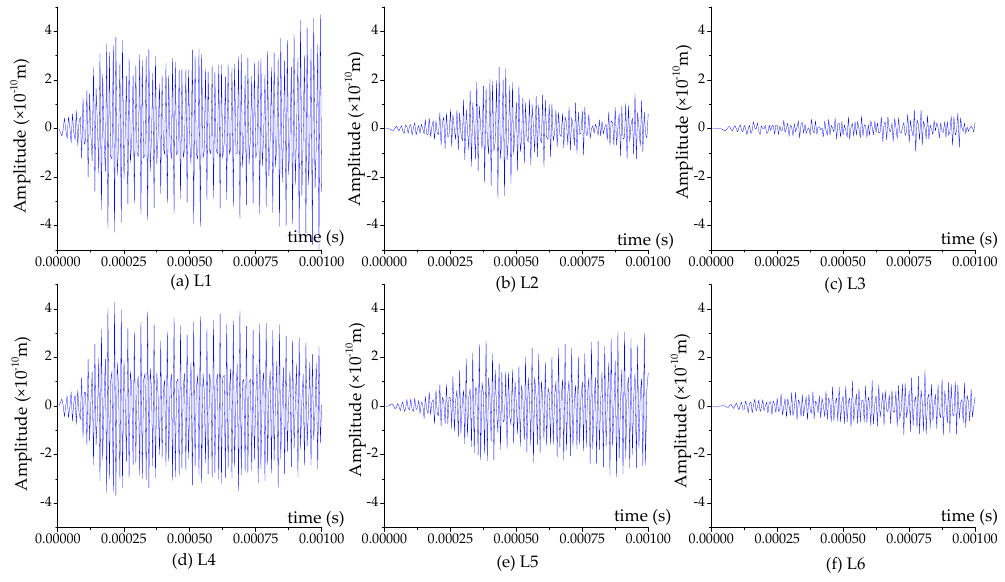
Figure 12. The displacement response at different locations at 100% grouting level.